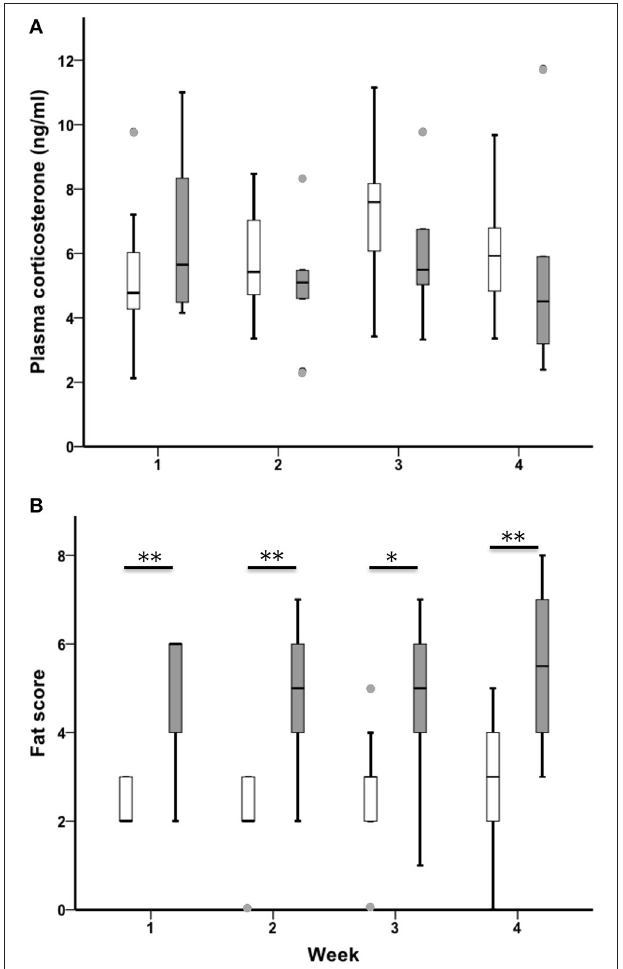
FIGURE 6 | Male sedentary urban juncos (white boxes) and male migrant juncos (gray boxes) did not differ in FSHR (A) or LHR (B) transcript abundance in the gonad. Measures of transcript abundance are log 2 -fold change relative to a calibrator. Boxes represent upper quartile, median, and lower quartile. Whiskers include the range of values except for outliers. Outliers include values > 1.5 box lengths (circles).